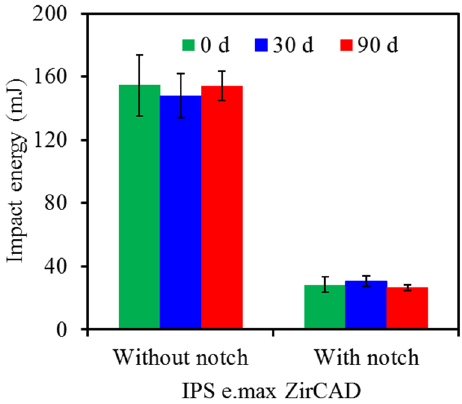
Figure 5. Impact energy of IPS e.max ZirCAD without and with notch before and after soaking in pH 7 artificial saliva.